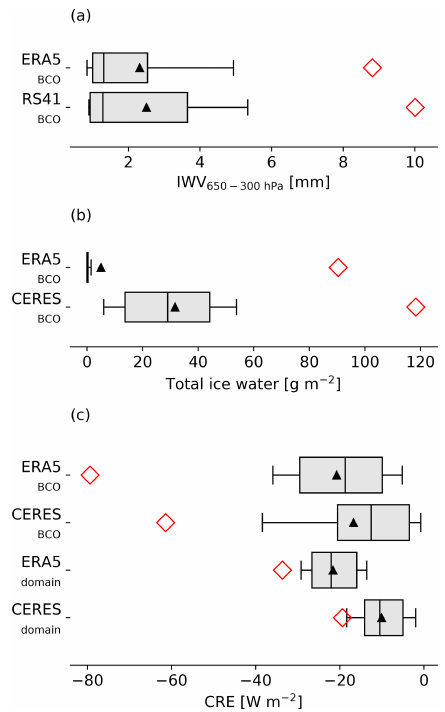
Figure 13. Boxplots of (a) daily mean IWV 650–300hPa from ERA5 and the atmospheric soundings (RS41) at the BCO, (b) daily mean total ice water from ERA5 and CERES (note that many data points are based on spatial interpolation due to missing data; see Fig. 3) at the BCO, and (c) daily mean CRE from ERA5 and CERES at the BCO and as area-weighted mean over the domain 10–20 ◦ N, 50– 60 ◦ W (red box in Fig. 5a; ERA5 domain and CERES domain ). The boxplots (25th, 75th percentiles as box; 10th, 90th percentiles as whiskers; median as line in the box, mean as black triangle, outliers not shown) show values of 36d (16 January to 20 February 2020). The values on 14 February 2020 are shown as red